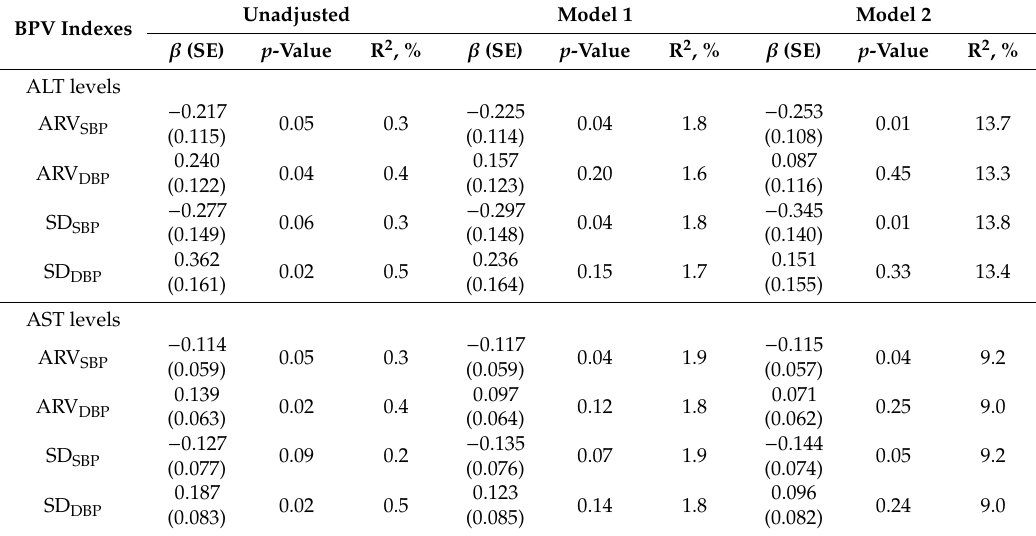
Figure 2. Serum liver transaminase levels in quantiles of average real variability (ARV) BP and standard deviation (SD) BP . Bars represent means (95% confidence intervals) with adjustment for systolic blood pressure (SBP) and diastolic blood pressure (DBP). p -values were calculated by ANCOVA. Table 2. Association of serum alanine transaminase (ALT) and aspartate transaminase (AST) levels with long-term blood pressure variability in multivariable liner